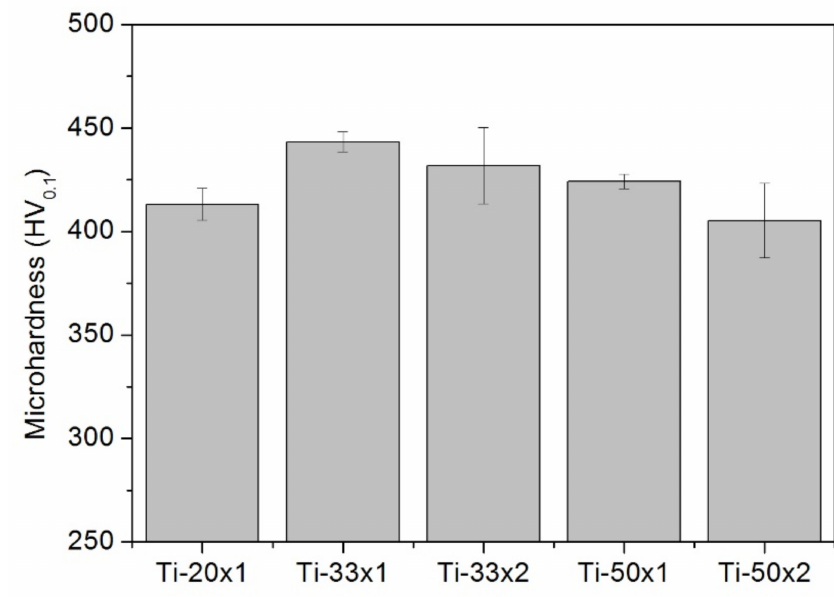
Figure 10. HV 0.1 microhardness of the samples manufactured.